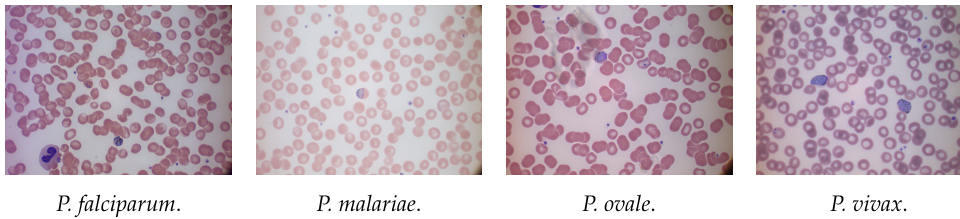
P. falciparum . Figure 2. Example of the four types of malaria parasites of